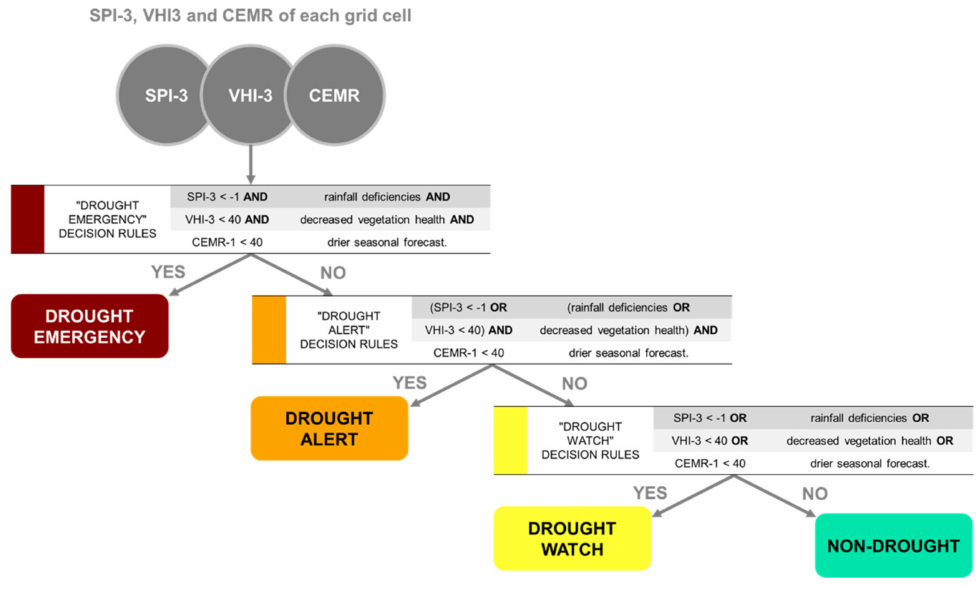
Figure 2. Drought I-EWS decision rule